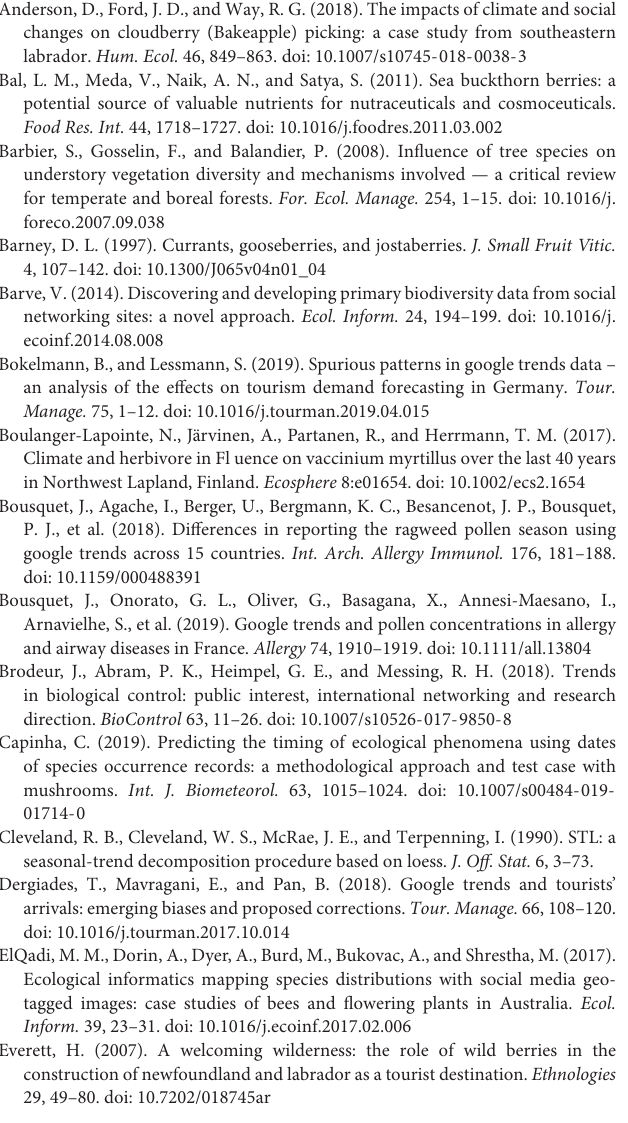
Supplementary Figure 1 | Trend-deducted relative search volume from 2011 to 2020 of (A) lingonberry, (B) cranberry, (C) bog bilberry, (D) European blueberry, (E) currant, (F) gooseberry, (G) cloudberry, (H) raspberry, (I) honeysuckle, and (J) sea buckthorn across Russia. Supplementary Figure 2 | Monthly relative search volume (RSV) for 10 years from 2011 to 2020 of four benchmarks as computer (blue), software (cyan), life (green), and love (red). Supplementary Figure 3 | Monthly relative search volume (RSV) corrected with four benchmarks for 10 years from 2011 to 2020 of (A) lingonberry, (B) cranberry,